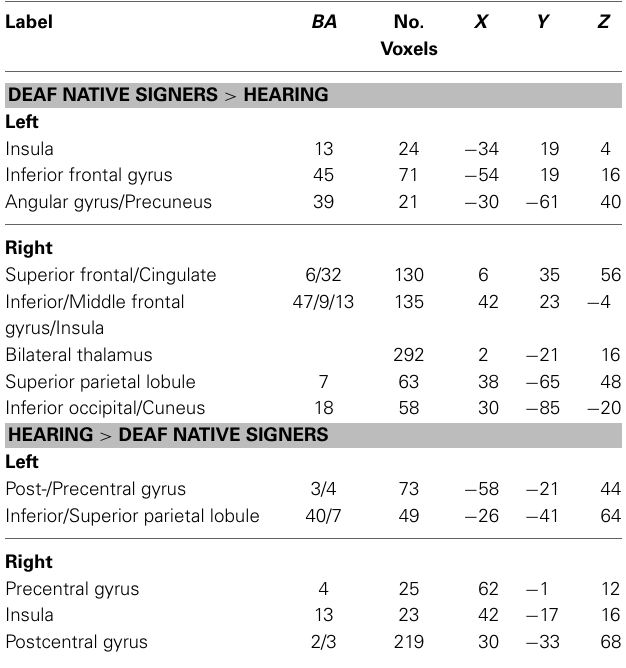
differed between hearing and deaf native signers, p < 0 . 05